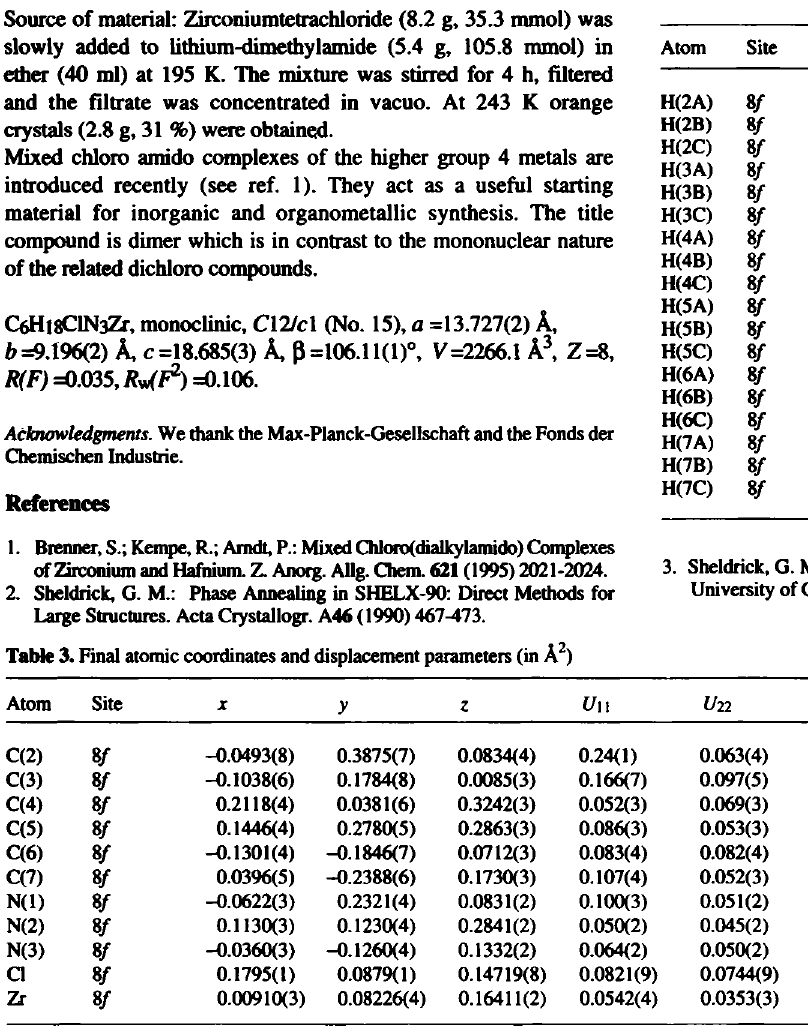
Table 2. Final atomic coordinates and displacement parameters (in Â 2